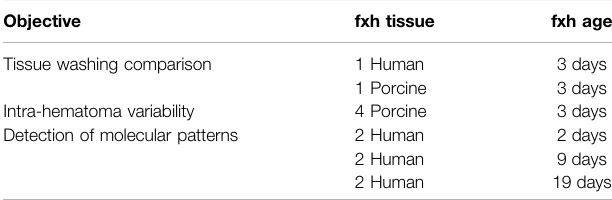
TABLE 1 | Overview of fxh tissues and ages used for the different objectives.